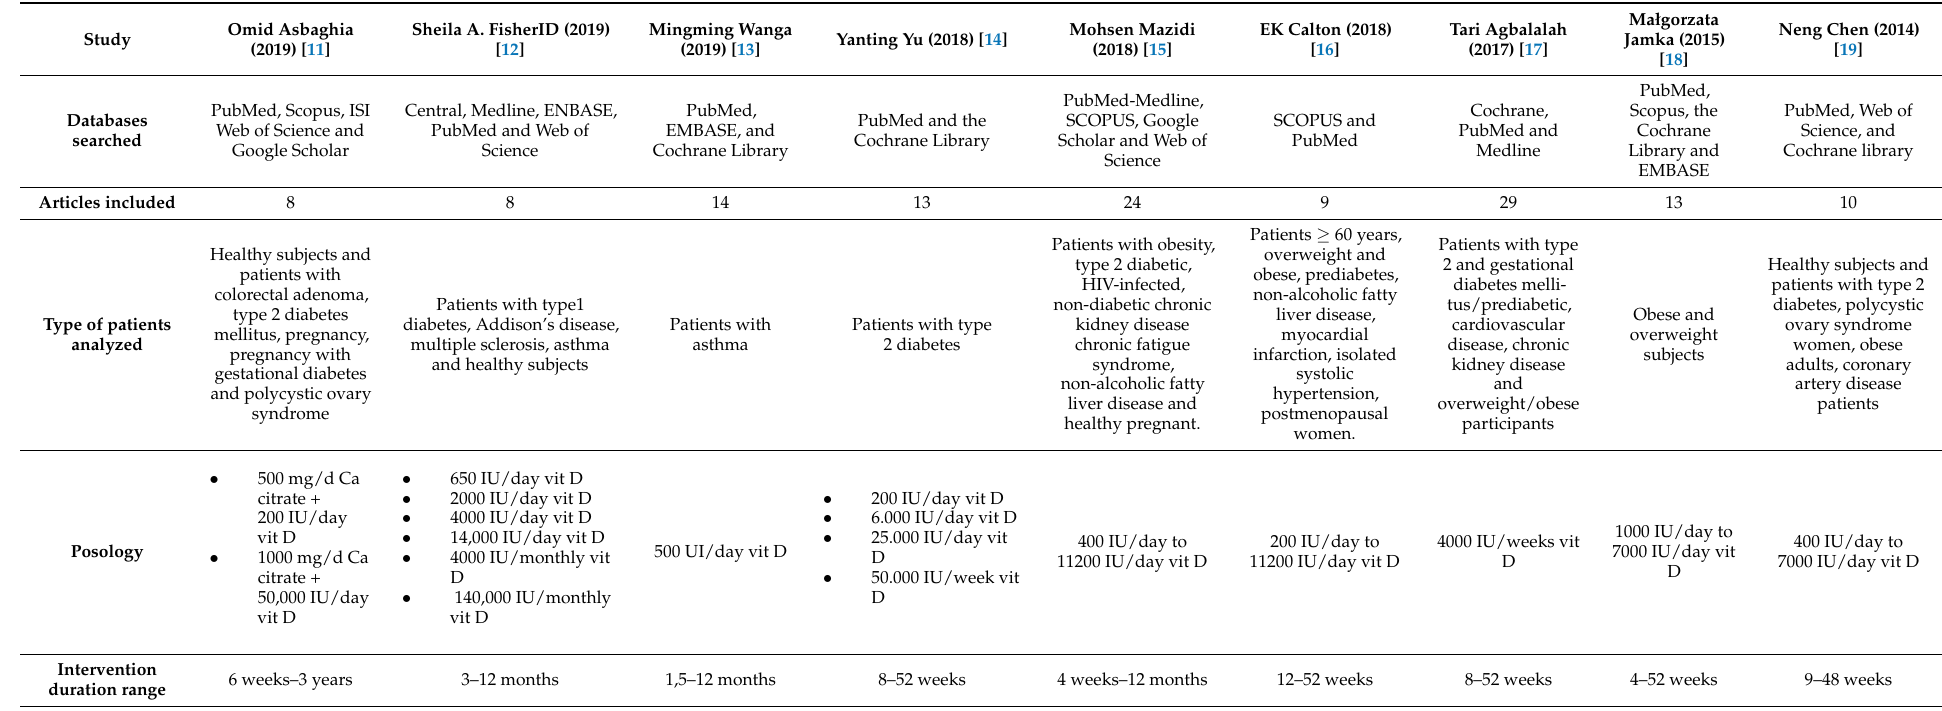
Table 1. Vitamin D: characteristics of the included systematic